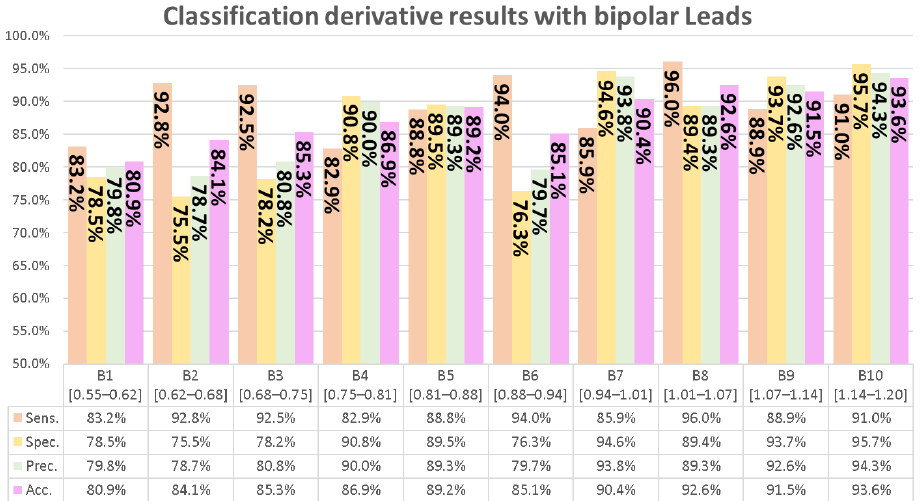
Figure 8. Single lead confusion matrix derivation results.